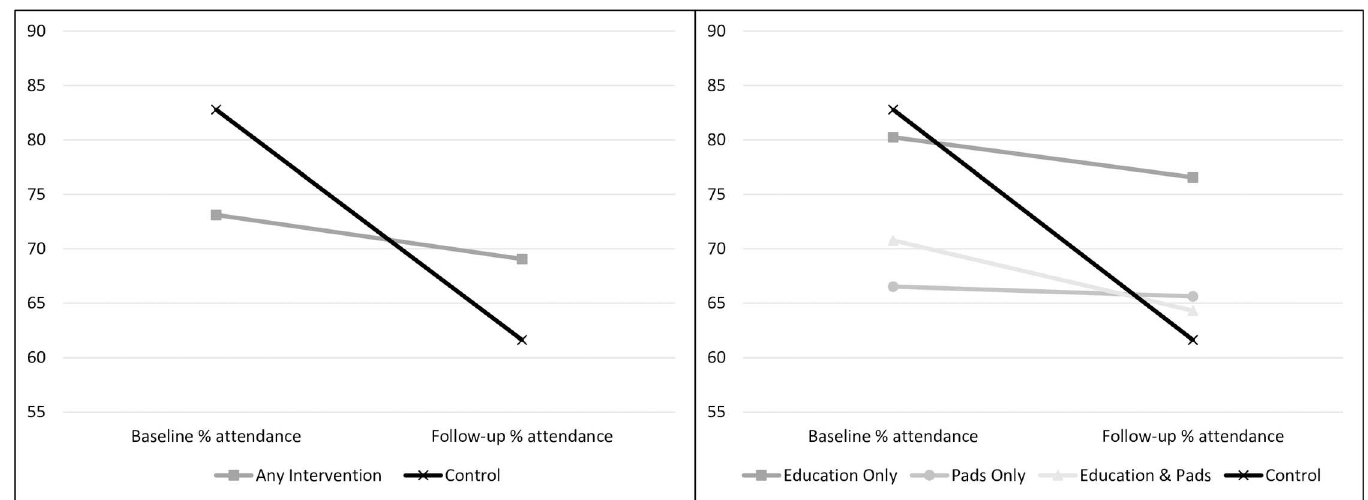
Fig 3. Mean percentage attendance at baseline and follow-up for all interventions combined, and each condition, compared to control. Presented for the sample of girls retainedin schools at follow-up(n = 580).